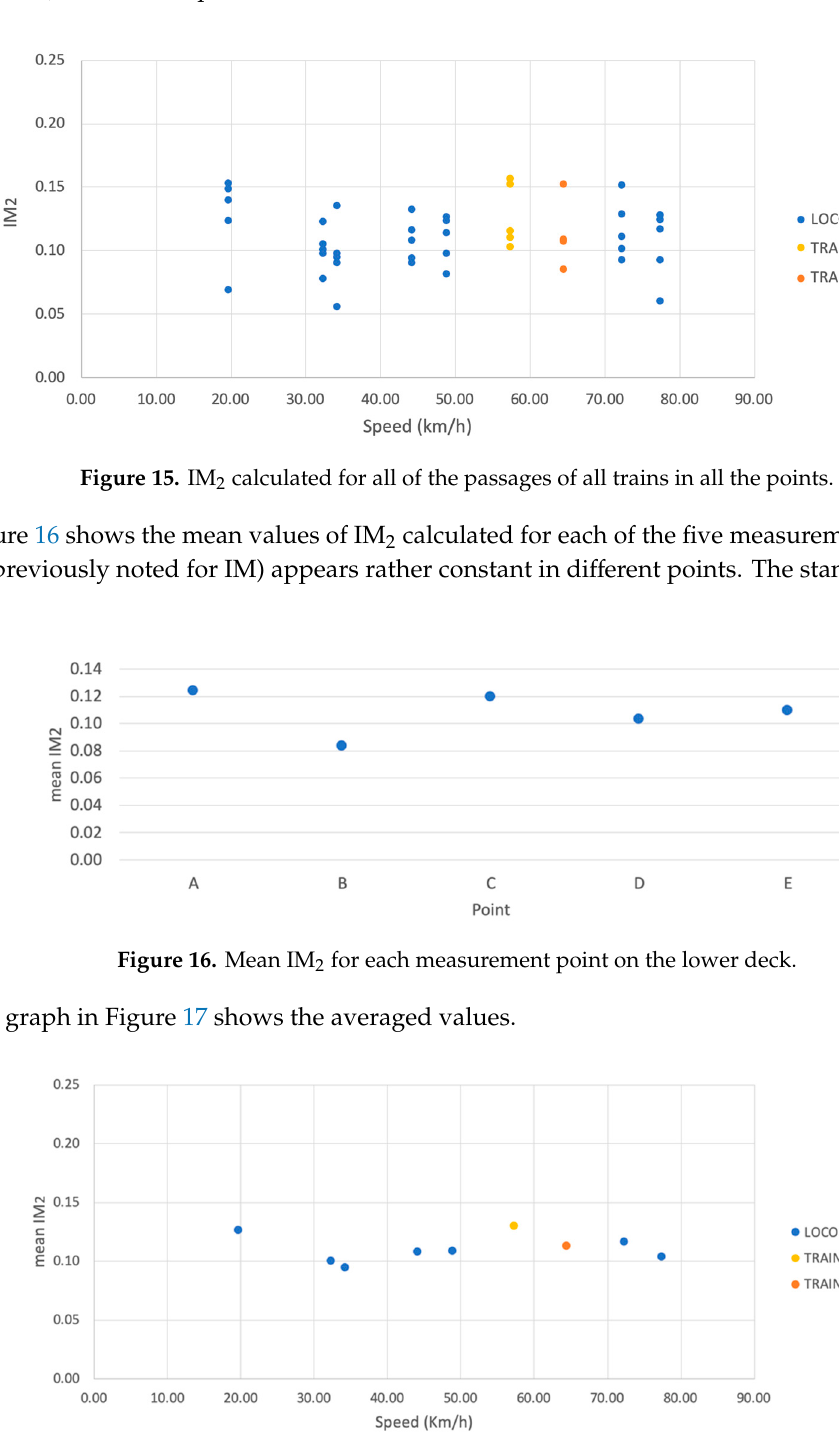
Figure 17. IM 2 calculated averaging the values of the five points on the span for each speed.